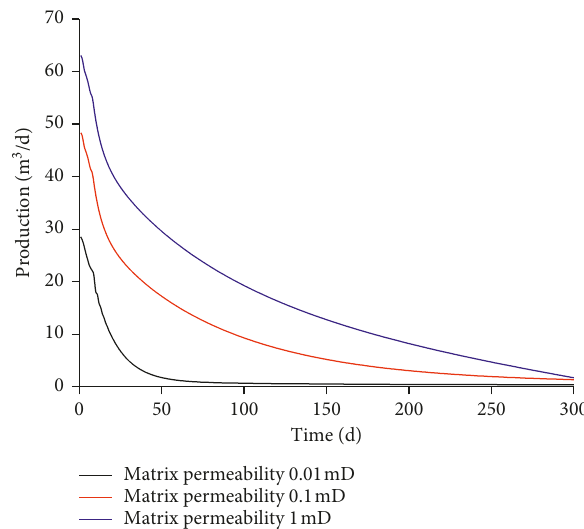
Figure 6: Production at a 300-day period with different matrix permeability.